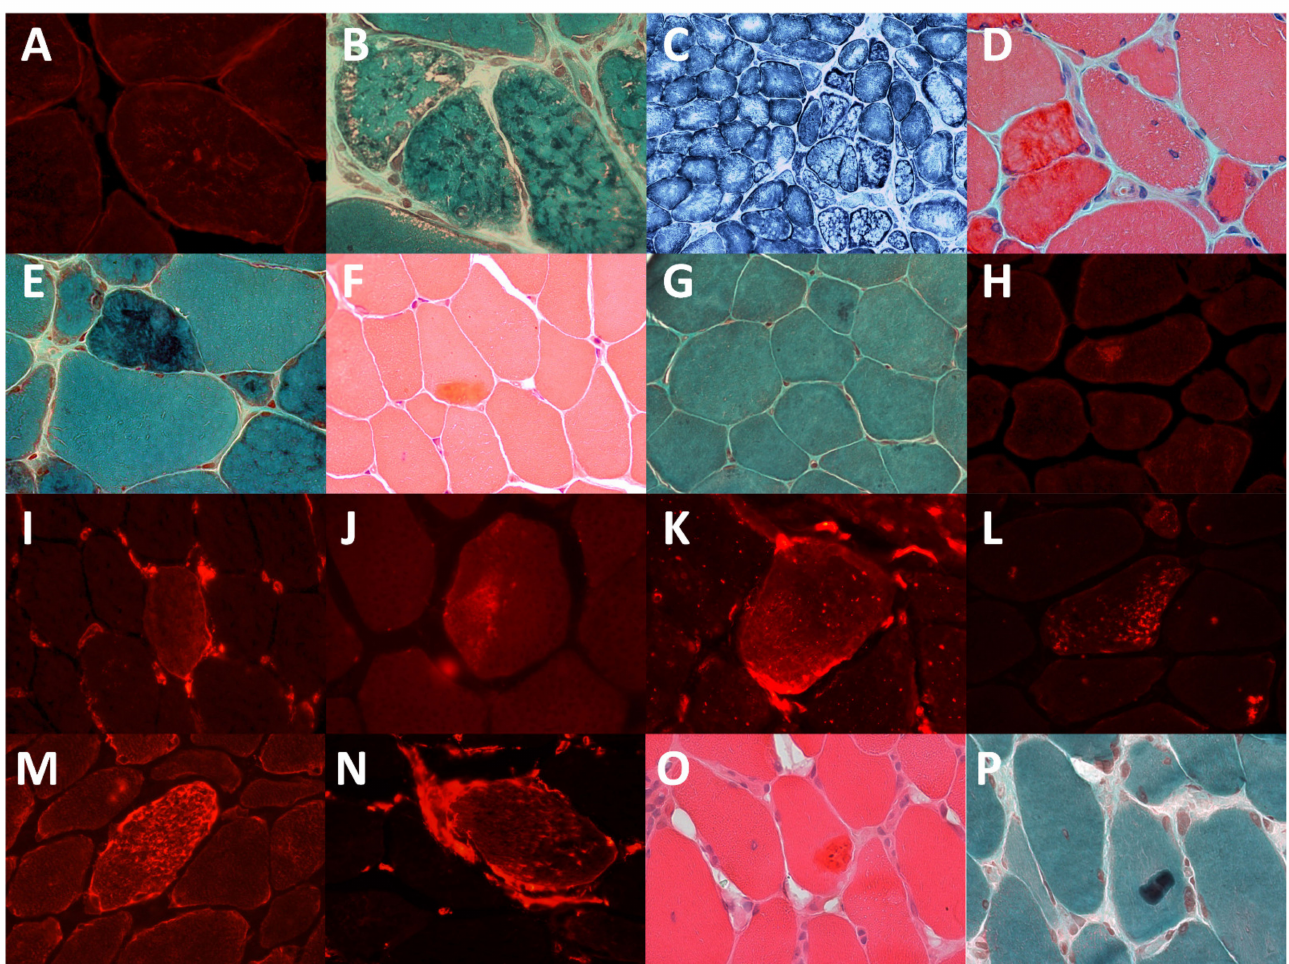
Figure 1. Immunohistochemistry and light microscope images of muscles of the patients. ( A ). Patient 2: desmin aggregates ( B ). Patient 2: small reddish or dark inclusions in the Gomori trichrome staining. ( C ). Patient 2: lobulated fibers visible in the succinate dehydrogenase staining. ( D ). Patient 3: dark red material in the hematoxylin and eosin staining. ( E ). Patient 3: dark blue material in the trichrome staining. ( F ). Patient 5: acidophilic inclusions in the hematoxylin and eosin staining, ( G ) Patient 5: acidophilic inclusions in the trichrome staining. ( H ). Patient 5: desmin aggregates. ( I ). Patient 5: vimentin aggregates. ( J ). Patient 6: CRYAB aggregates. ( K ). Patient 6: vimentin aggregates. ( L ). Patient 11: CRYAB aggregates. ( M ). Patient 11: desmin aggregates. ( N ). Patient 11: vimentin aggregates. ( O ). Patient 11: large acidophilic inclusions in the hematoxylin and eosin staining, ( P ). Patient 11: acidophilic inclusions in the trichrome